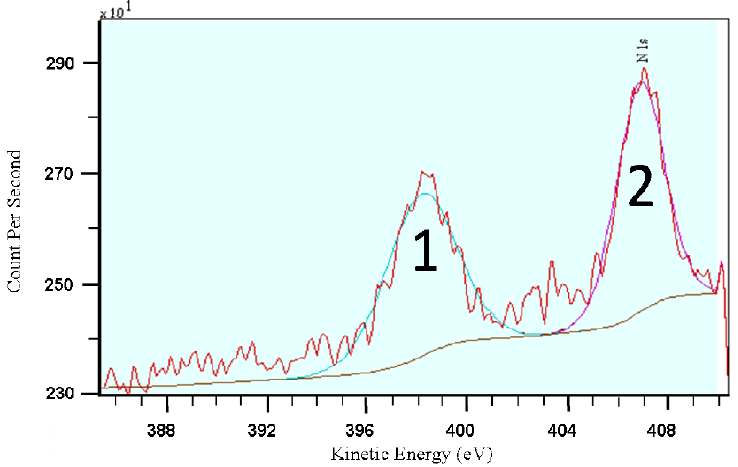
Figure 3. X-ray photoelectron spectroscopy (XPS) of electrodeposited